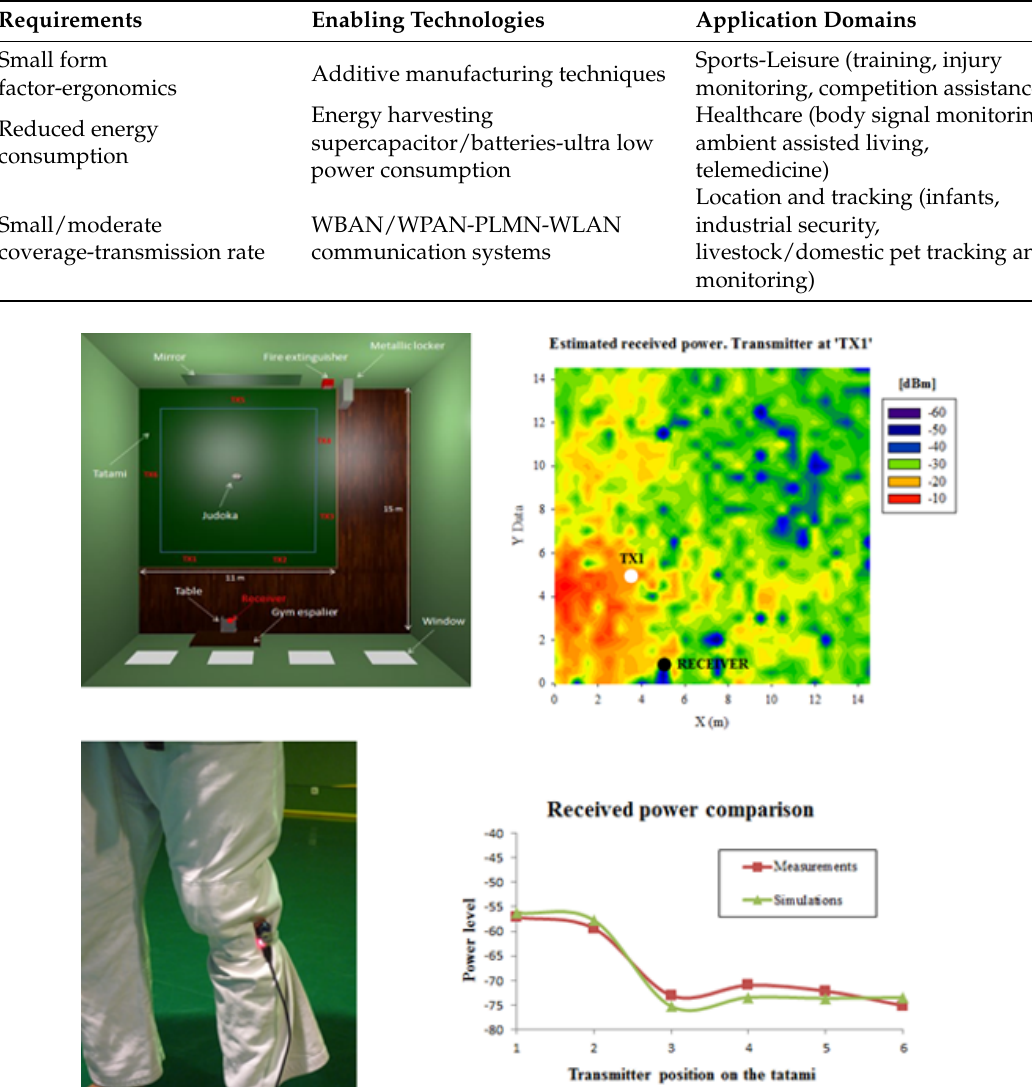
Table 4. Overview of wearable technology and applications in terms of fundamental requirements, enabling technologies and application domains.